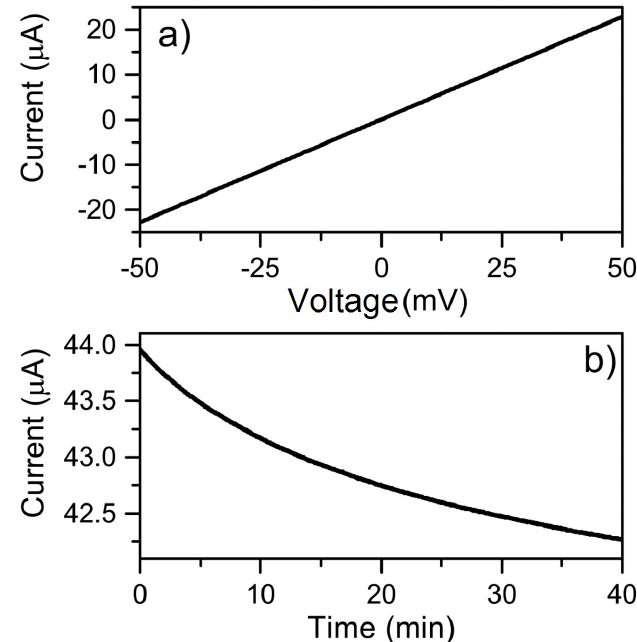
Figure 6. ( a ) Current–potential (I–V) measurement from –50 to 50 mV with no microfluidic system connected; ( b ) time development response with only phosphate buffered saline (PBS) as the pump liquid at 50 mV bias, deionized (DI) water as the pump solution shows the same